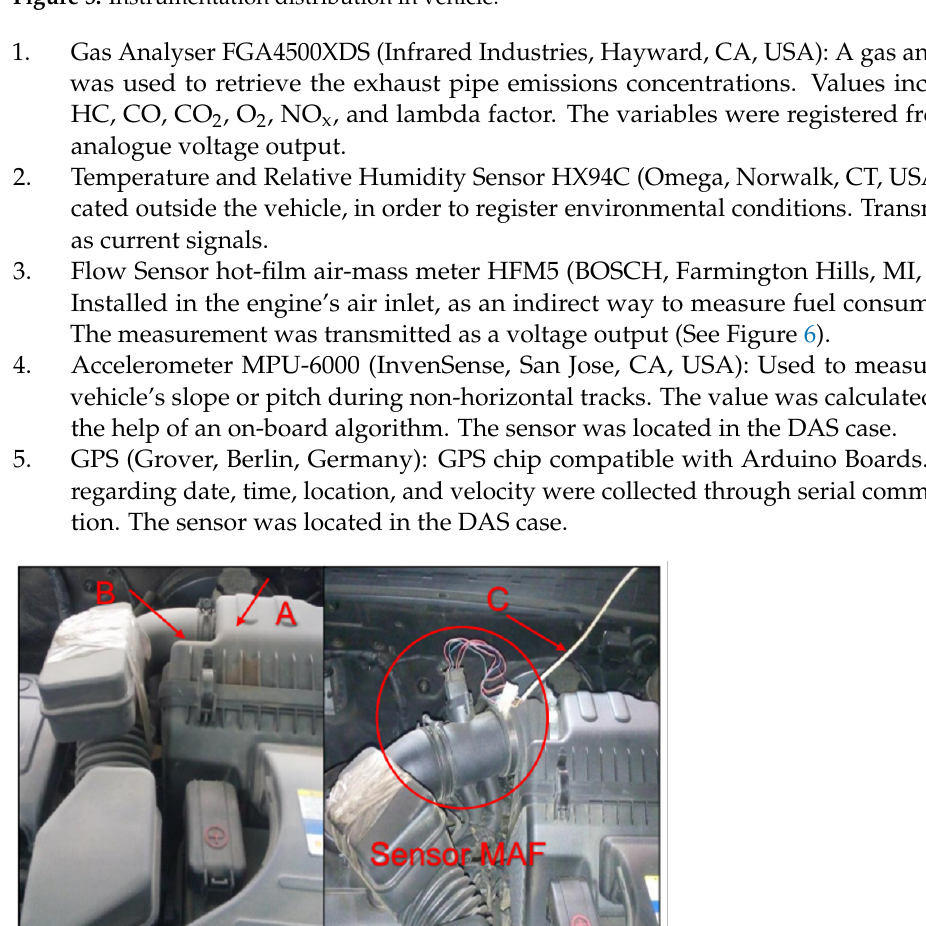
Figure 5. Instrumentation distribution in vehicle.